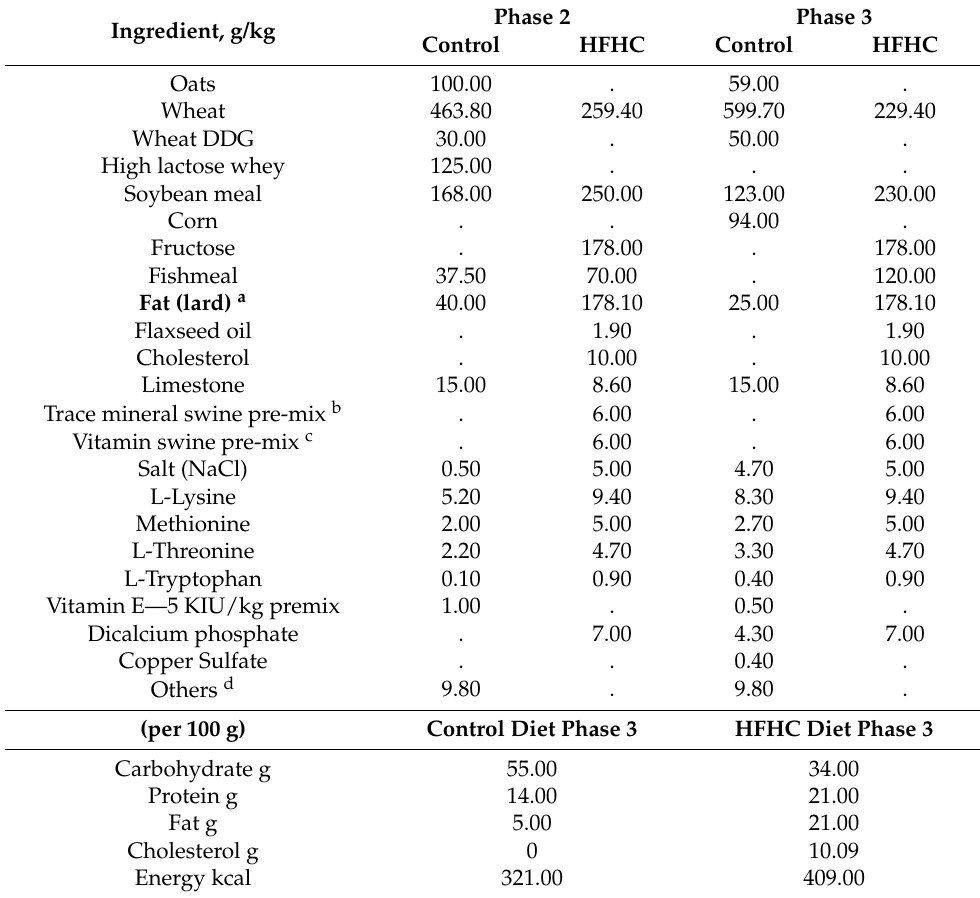
Carbohydrate g Protein g Fat